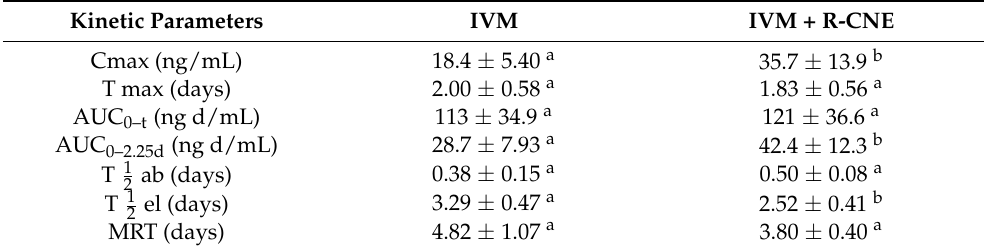
el, elimination half-life; AUC 0–t , 2